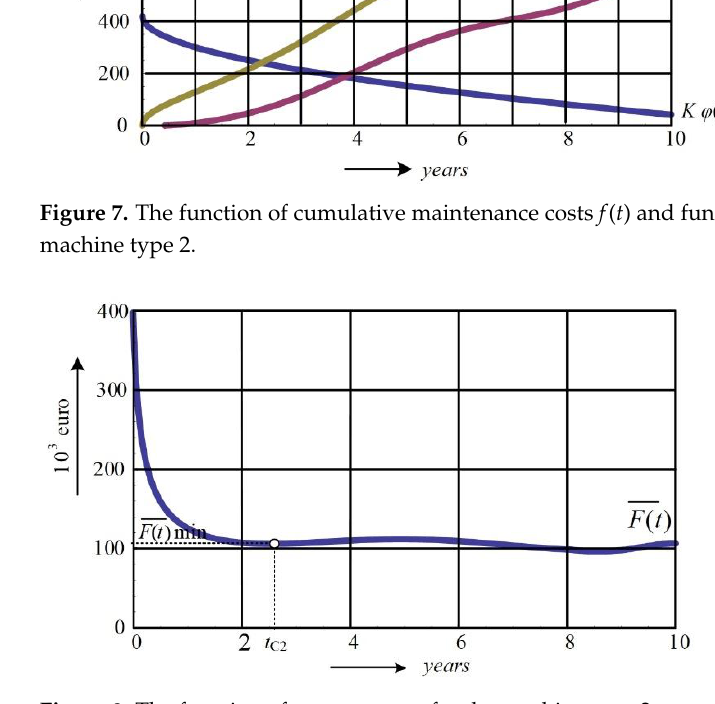
Figure 9. The first and second derivative of a function of average costs for the machine type 2. 4. Discussion Reference points of the dozer’s lifetime are defined by calculations , and an overview of the results is presented in Table 3. Transition moments from stage I into II and from stage II into III of the lifetime, for both dozers, are given in the table. As it can be seen, machine type 2 reaches both reference points earlier, with a more significant difference at the transition from stage I into stage II. Moreover, machine type 2 incurs larger costs and deteriorates faster. Table 3. Calculated results of costs analysis. Machine